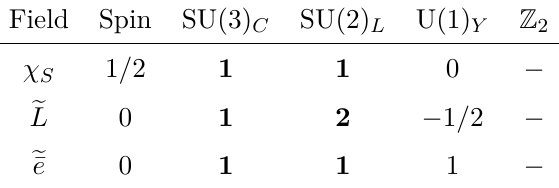
Table 2. New particles and their quantum numbers in Model